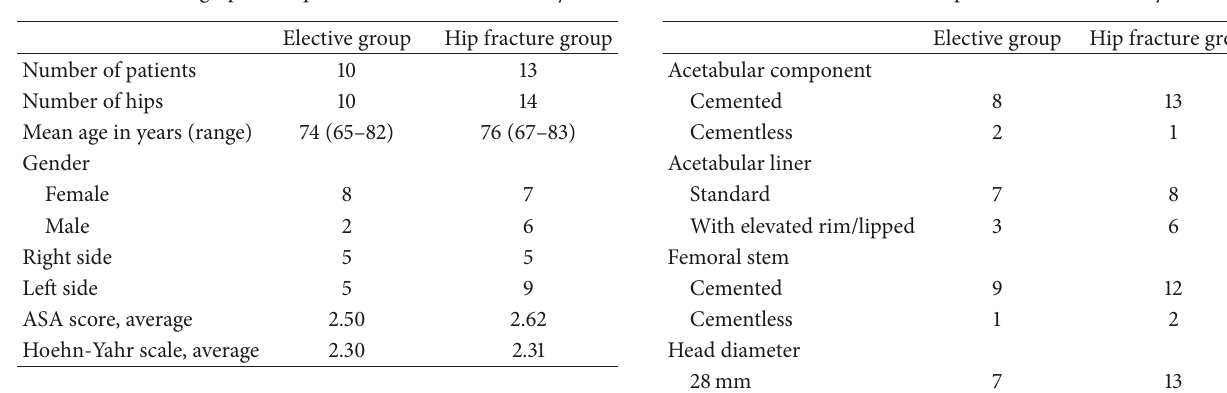
Table 1: Demographics of patients included in the study. Table 2: Details of implants used in the